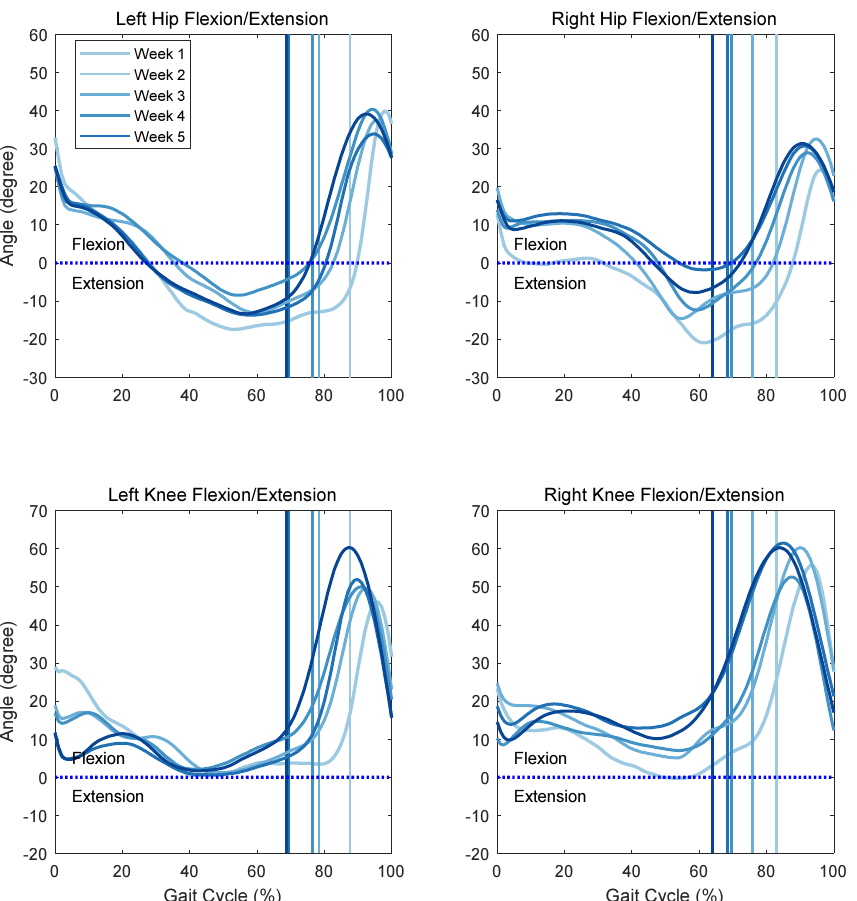
Figure 15. Kinematic results of five-week walking training with Angel Legs and using bilateral crutches. The bright lines represent the early stages of training, and the dark lines represent the later stages of the training. Vertical lines represent the start of swing